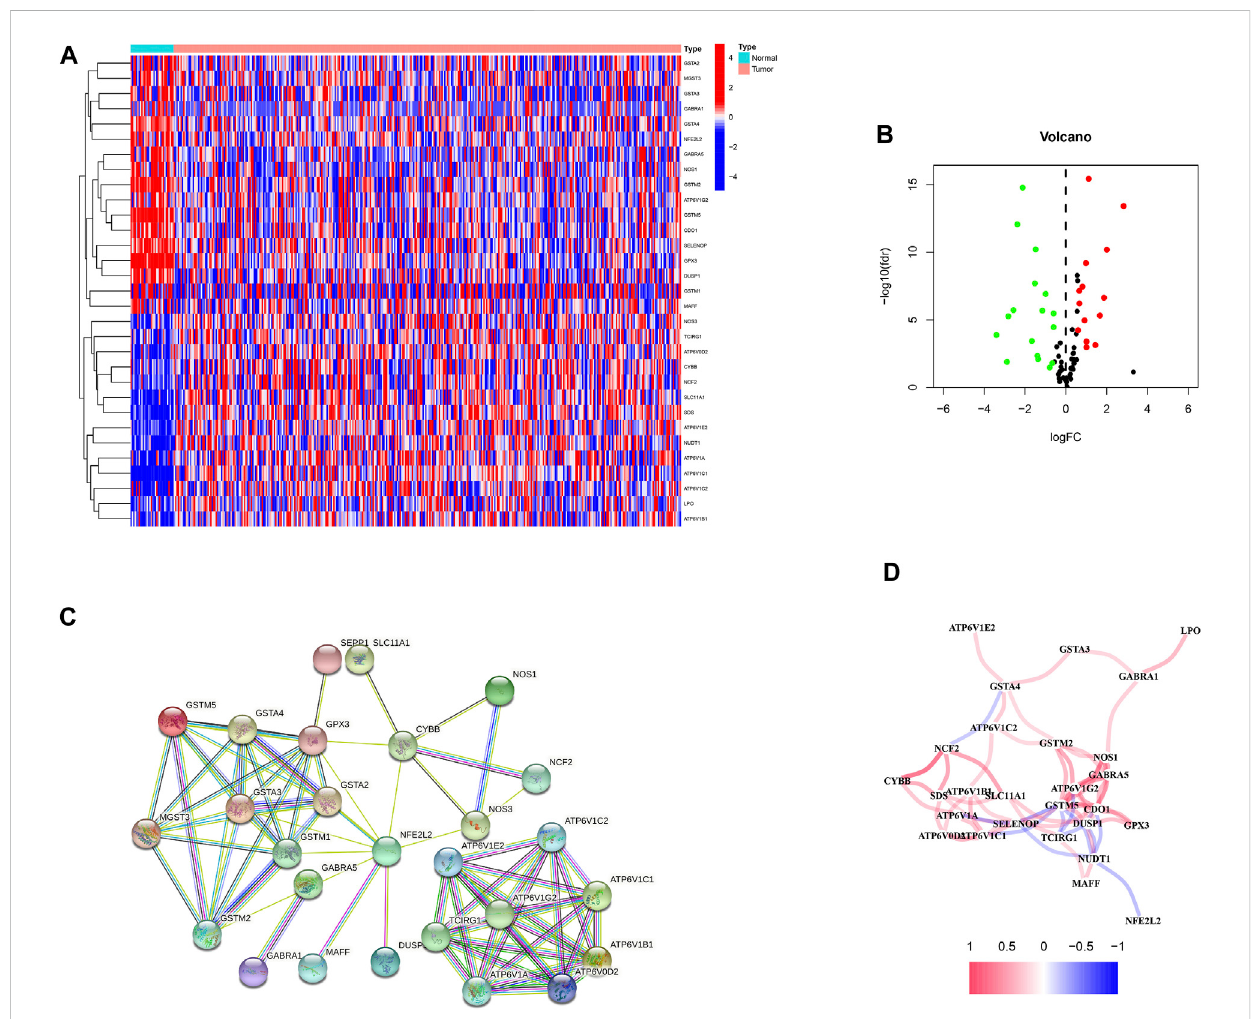
FIGURE 1 ROS-related genes in GC. (A) A heatmap of differentially expressed ROS-related genes in GC. (B) A volcano plot of ROS-related genes in GC. (C) A protein-protein interaction network. (D) A correlation network of ROS-related